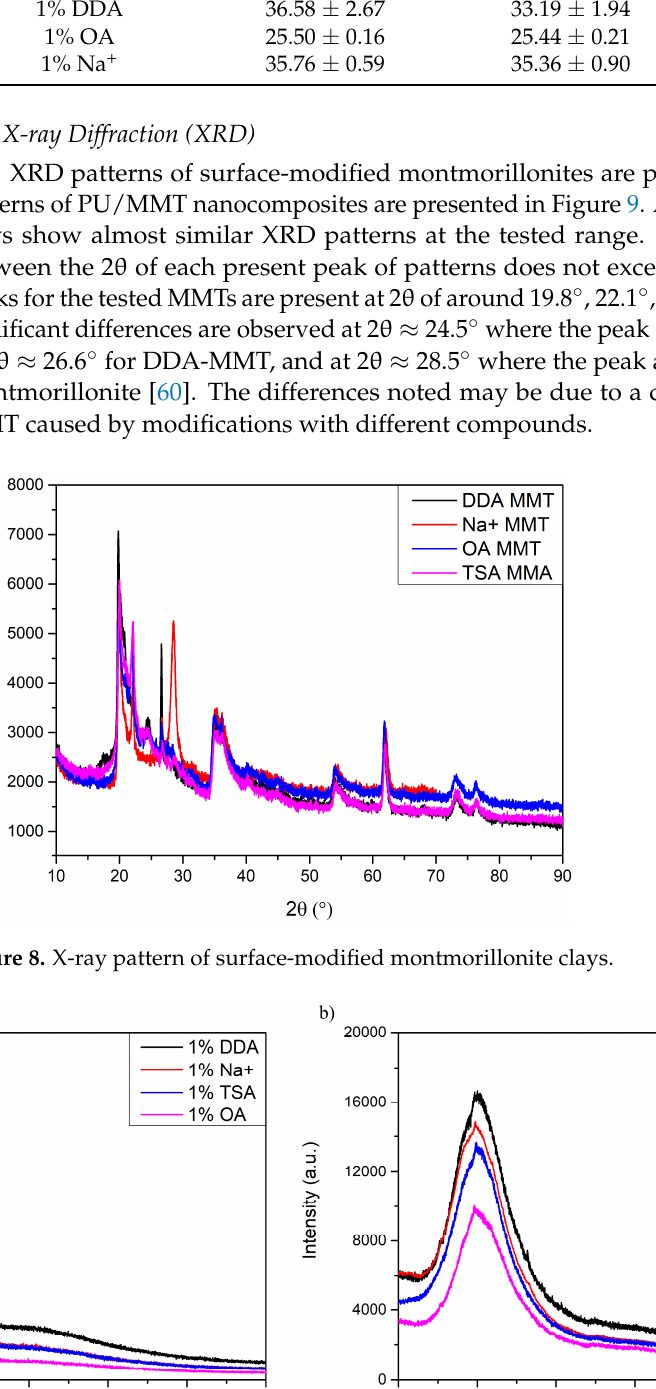
Figure 9. X-ray pattern of surface-synthesized PU/MMT nanocomposites. ( a ) Samples with 1% addition of MMT; ( b ) Samples with 3% addition of MMT.